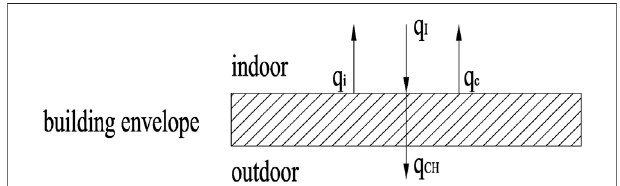
FIGURE 2 | Heat balance relationship of the building